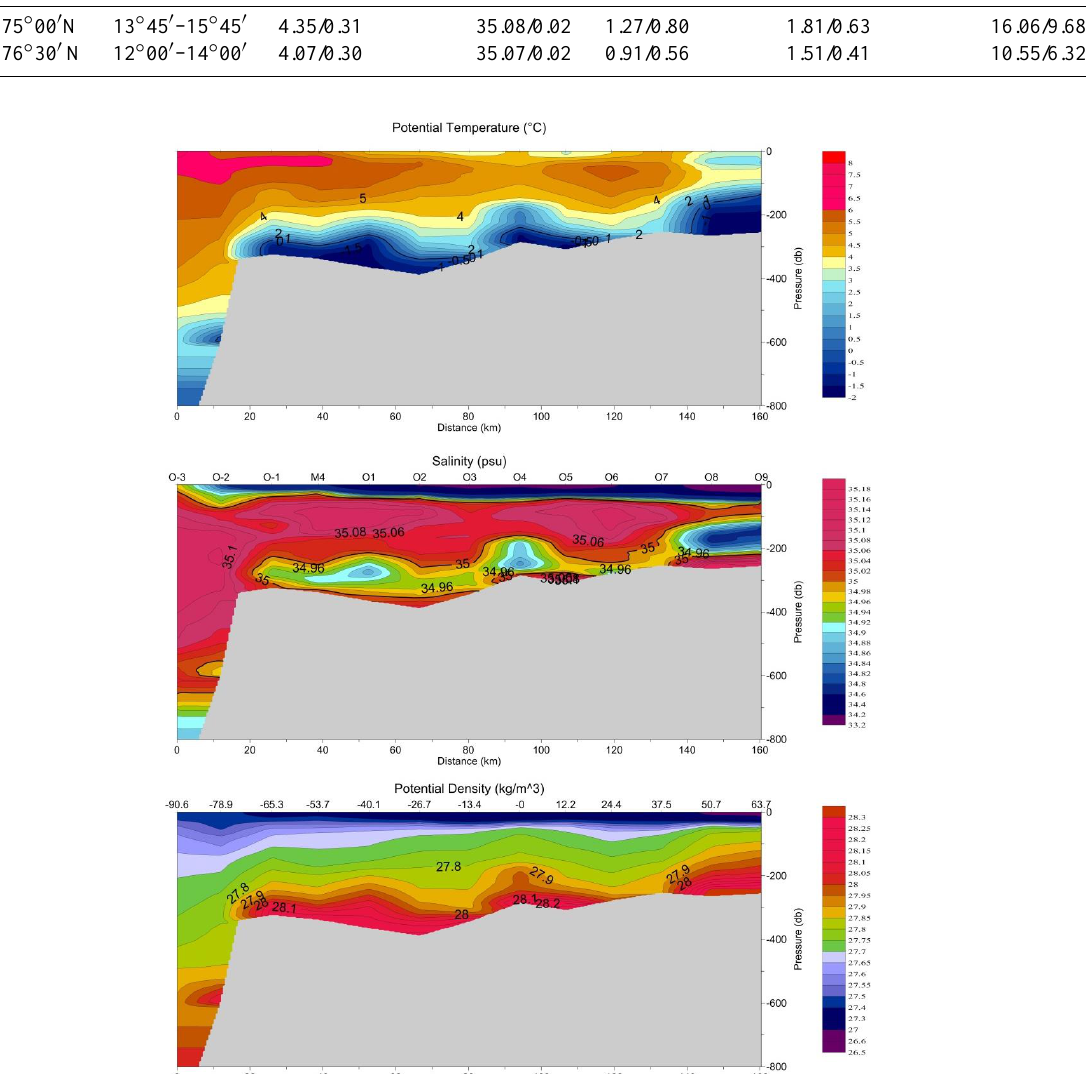
Fig. 17 equalled r = 0 . 64, p = 0 . 008 for temperature and r = 0 . 83, p = 0 . 0001 for salinity, without time lag. For de- trended data, the correlations are smaller: r = 0 . 48, p = 0 . 06 and r = 0 . 56, p = 0 . 02,